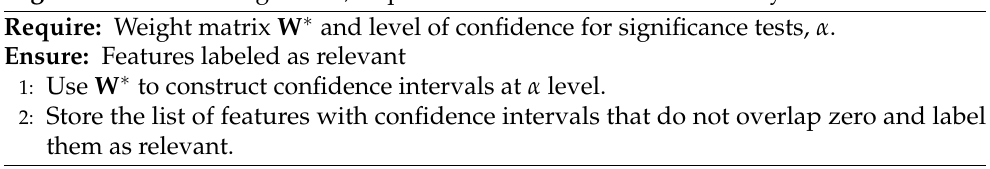
Algorithm 2 The IVI algorithm, step 2. Confidence intervals to identify relevant features.